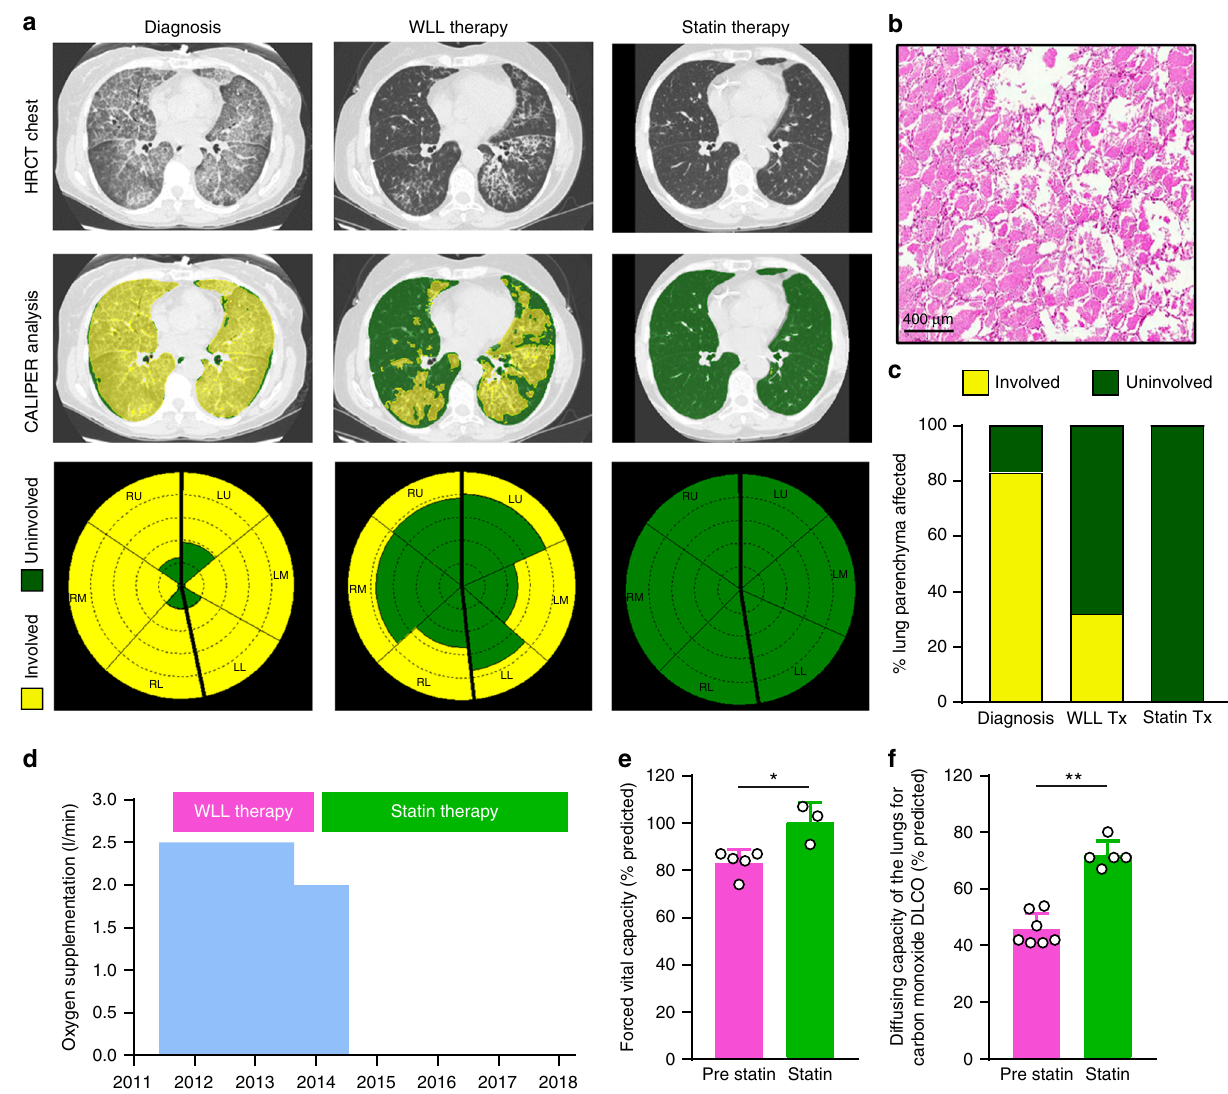
Fig. 1 Resolution of PAP associated with oral statin therapy. a HRCT chest at diagnosis and after WLL therapy or statin therapy. HRCT image illustrating quantitative categorical parenchymal-pattern analysis (green-masking: uninvolved/normal lung parenchyma, yellow-masking: PAP-involved/abnormal lung comprising ground glass and reticular changes). Glyphs showing parenchymal-pattern analysis of total lung parenchyma segmented by right, left; upper, middle, and lower zones. b Lung histology at diagnosis. Haematoxylin and eosin. c Percentage of lung affected by PAP determined by parenchymal-pattern analysis. Supplemental oxygen requirement ( d ), FVC ( e ), and DLCO ( f ) before and after statin therapy. Data are mean ± SD, statistical differences determined by Student ’ s t test or Mann – Whitney test. P < 0.05, ** P < 0.01, *** P < 0.001, **** P <